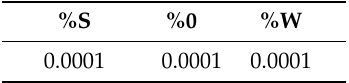
Table 7. Results of the Welch test for the SP factor ( p -value).